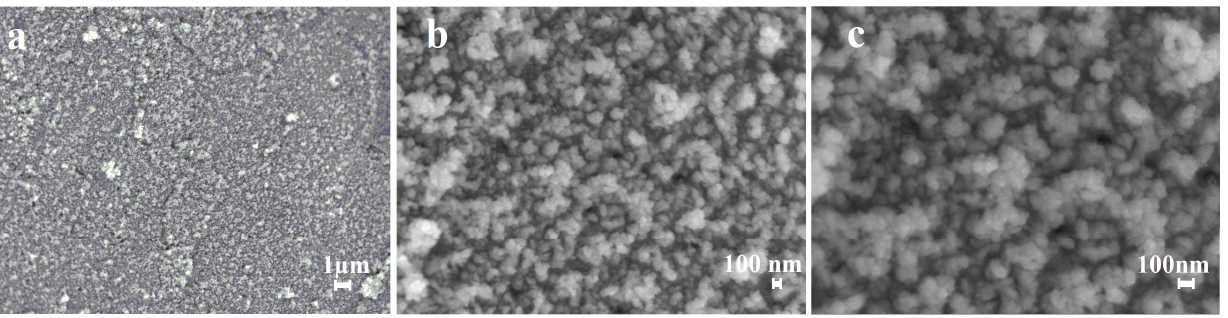
Figure 11. Cyclic voltammogram of a palladium catalyst. The synthesized platinoid catalyst based on palladium particles is an analogue of a commercial catalyst used in many industrial processes, including catalytic processes. This experiment was carried out to reliably compare the synthesized copper particles with dif- ferent morphology as a catalyst for the oxidation of alcohols with widely used platinum catalysts. 3.4. Comparison of Characteristics of Obtained Copper Catalysts with Analogues Table 1 presents analogues that have been reported in the literature in recent times for a comparative assessment of the parameters of the developed copper catalysts.